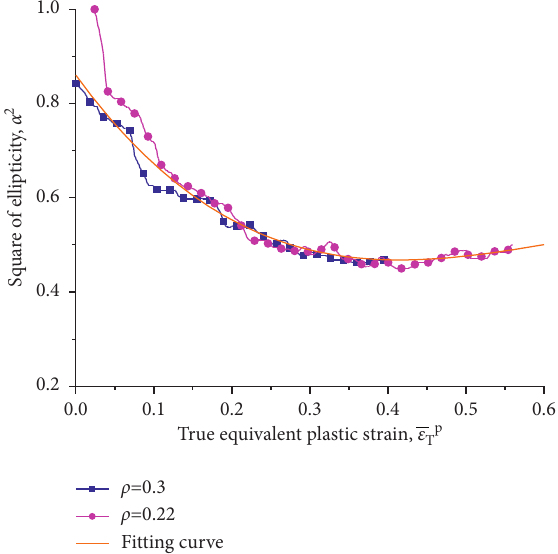
Figure 17: Uniaxial and hydrostatic stress-strain curves for closed- cell aluminum foams with different relative densities. Figure 18: The square of ellipticity for two kinds of aluminum foams and their fitting